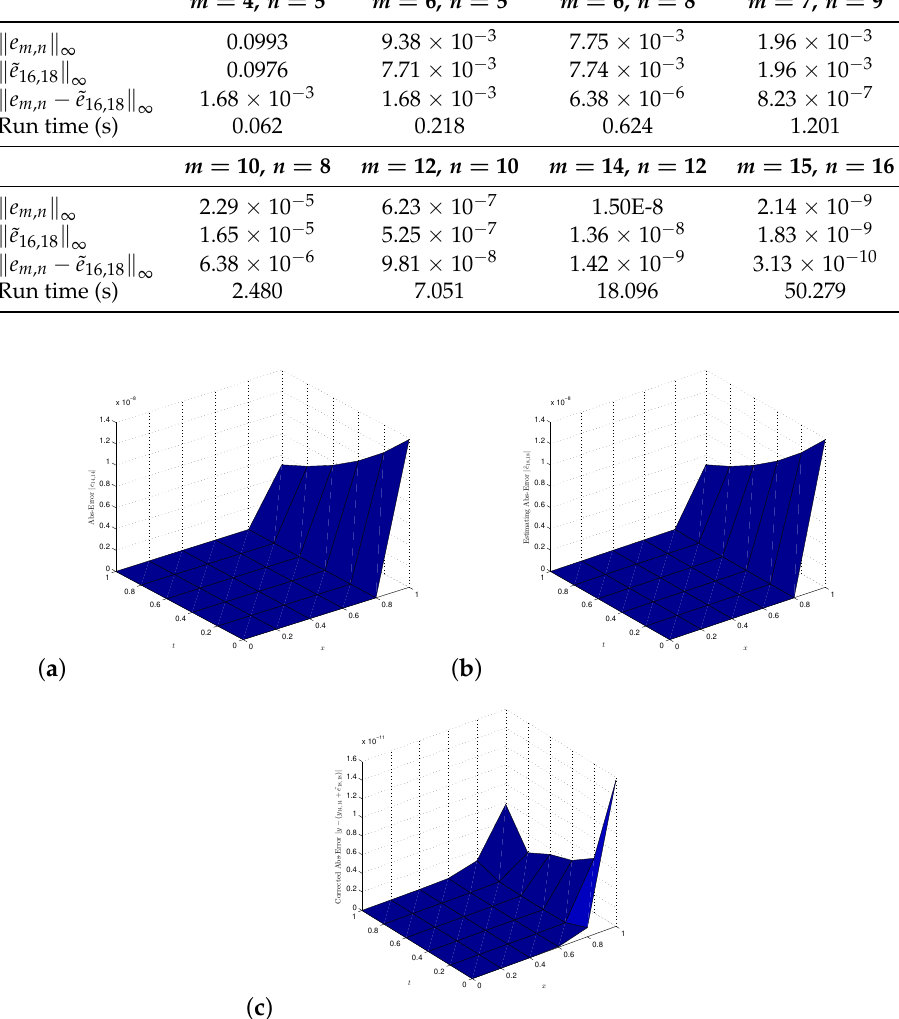
Figure 3. ( a ) absolute error; ( b ) estimated absolute error; ( c ) corrected absolute error for 2D-BPs solution for Example